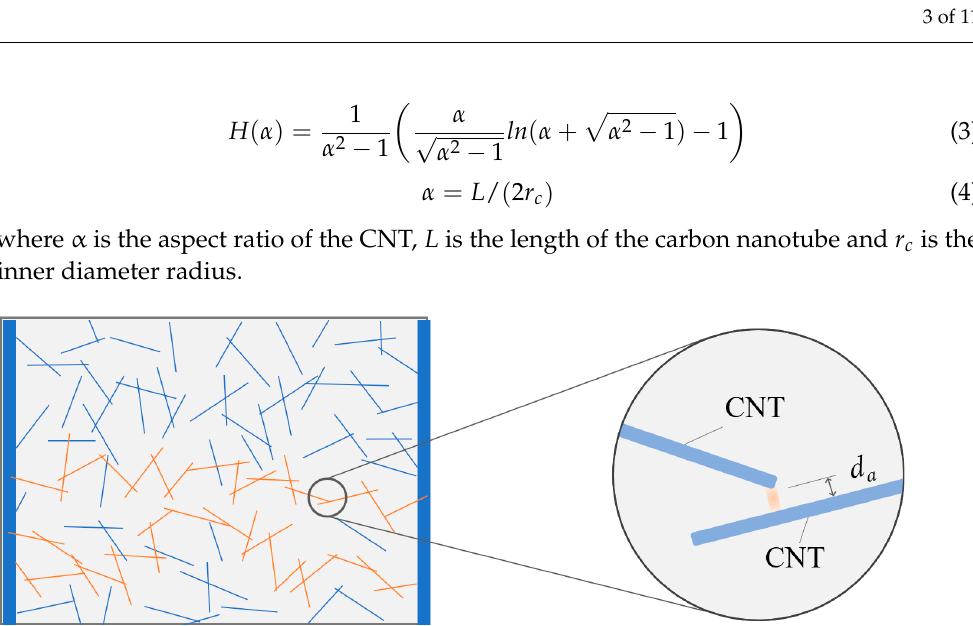
Figure 1. Schematic diagram of the random distribution of carbon nanotubes in resin and the average spacing between carbon nanotubes.